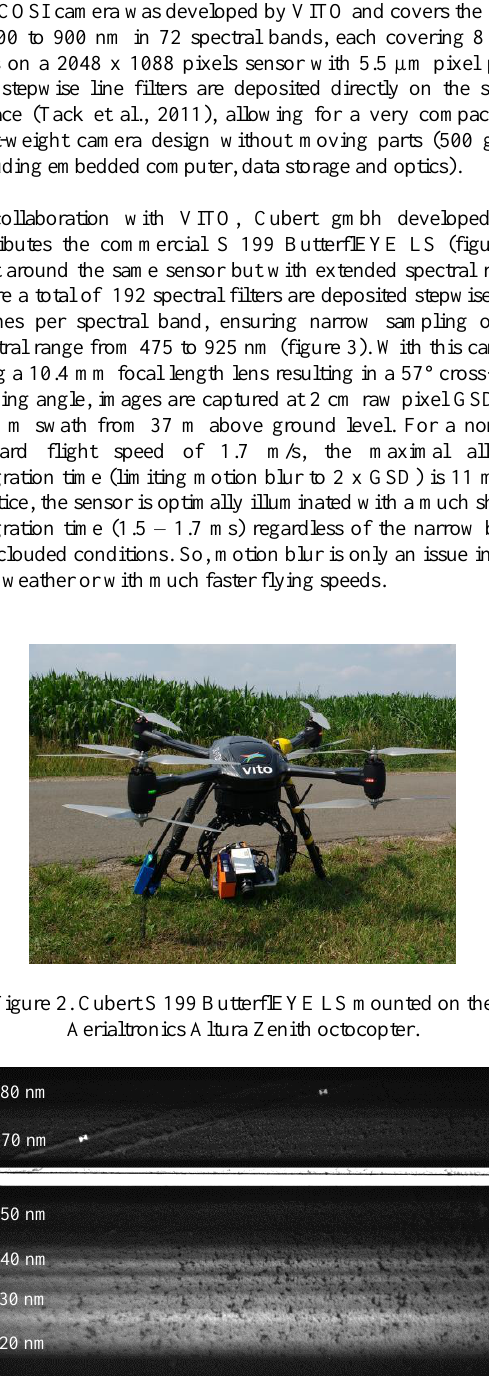
Figure 3. Raw image of a flowering potato field from the Cubert S 199 ButterflEYE LS spatio-spectral camera, showing the spectral band layout on the sensor. Some pixel lines between the green and red bands have no spectral filters deposited on them and are overexposed. These lines are discarded in